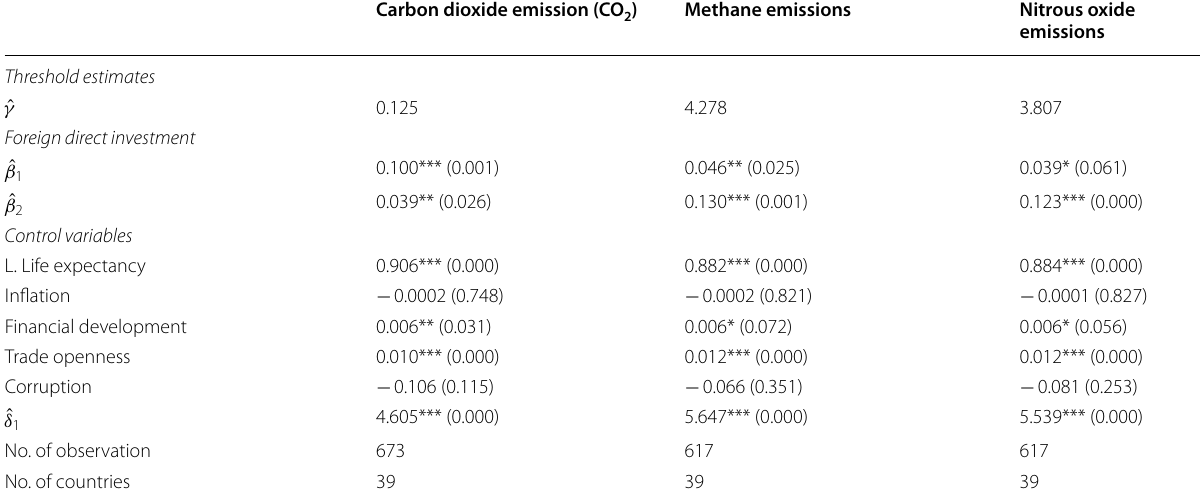
Table 3 Results of the dynamic threshold effect of the environmental degradation on foreign direct investment and poverty reduction (dependent variable: life